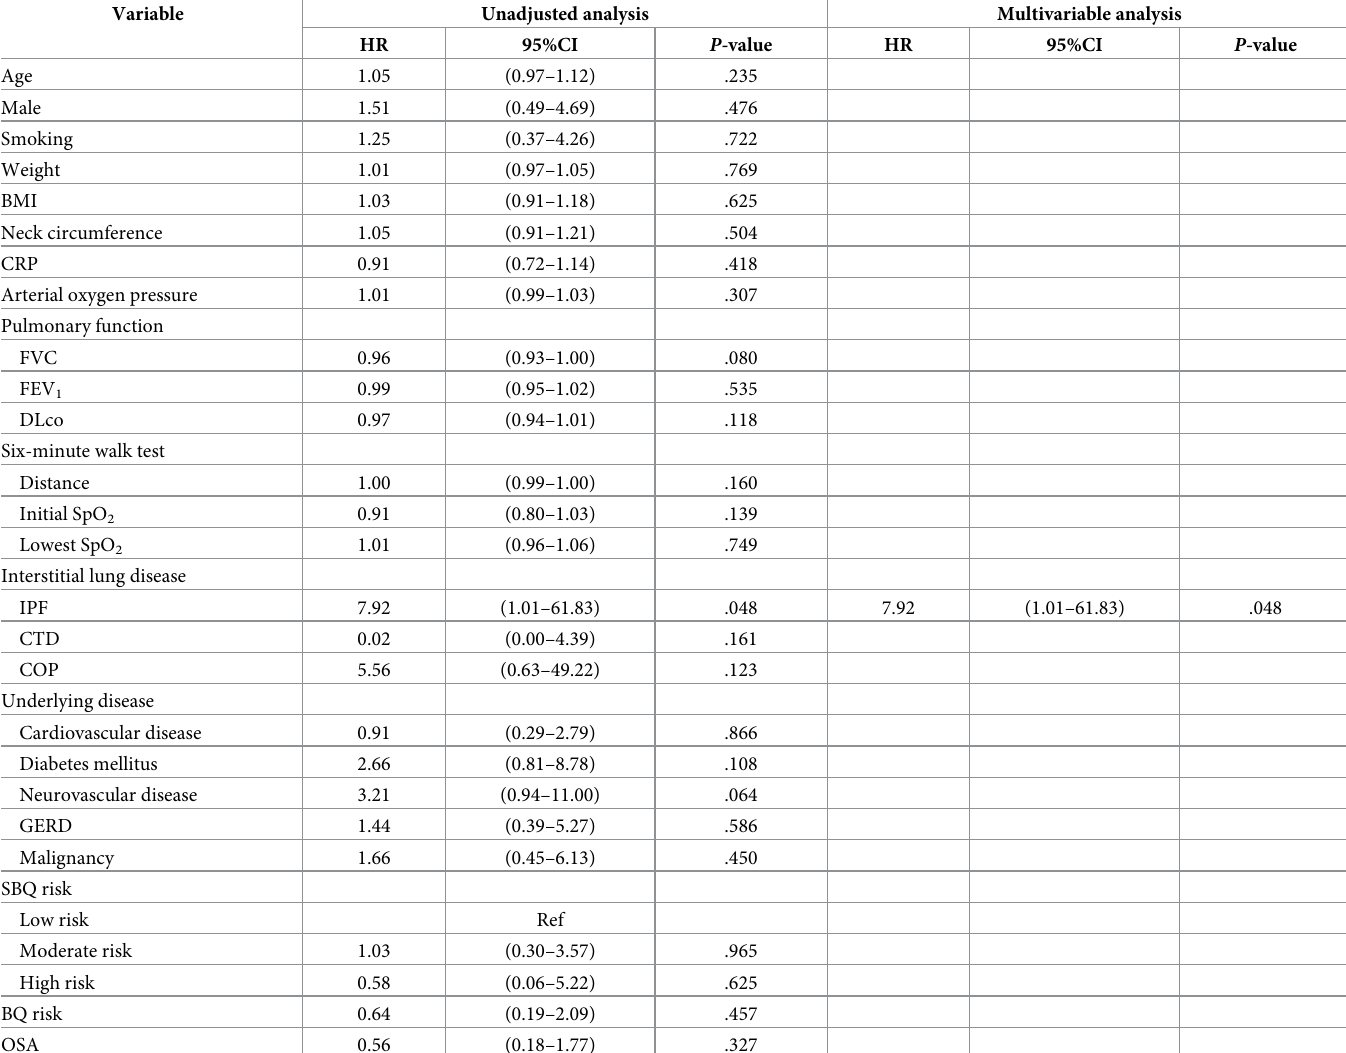
Table 4. Prognostic factor for mortality in patients with ILD assessed using Cox proportional hazards